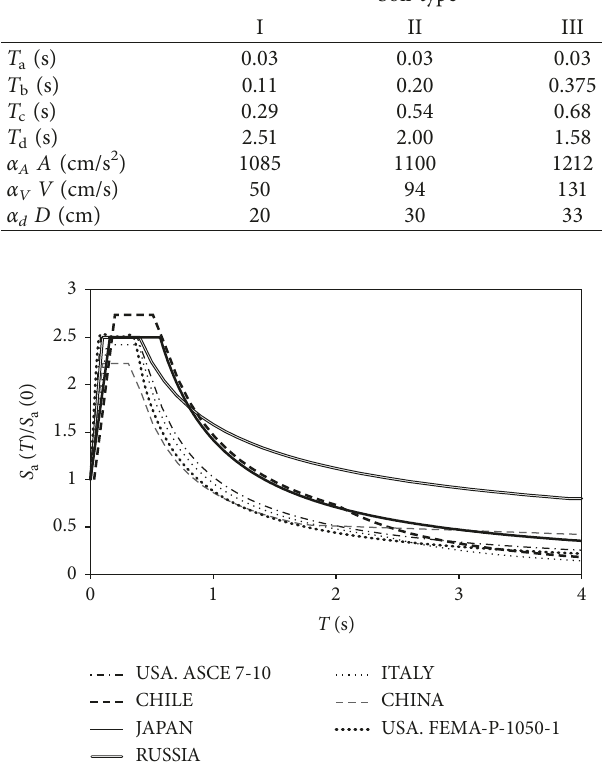
Figure 4: Design spectra for the examined codes. Source: